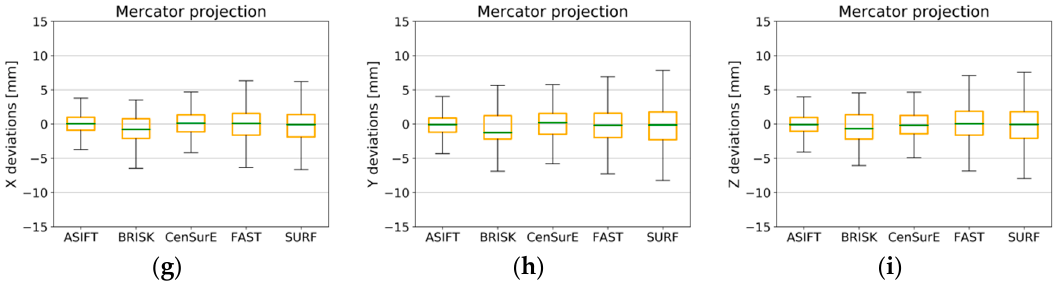
Figure 21. Box plots for the distribution of the deviations of natural check points for all pairs of fully registered scans (without points used for the ICP and non-registration) for Test Site III. The spherical projection: component—x ( a ), y ( b ), and z ( c ); orthoimages: component—x ( d ), y ( e ), and z ( f ); the Mercator projection: component—x ( g ), y ( h ), and z ( i ).